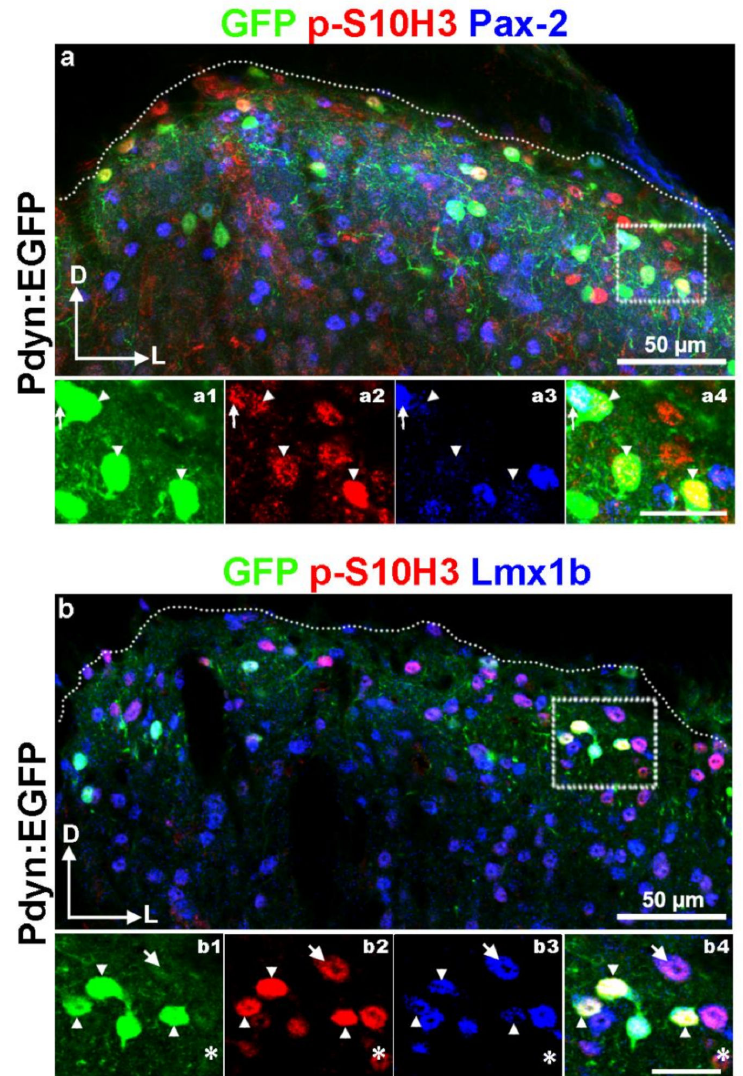
Figure 8. Burn injury-induced p-S10H3 nuclei are dominantly expressed by the excitatory subpop- ulation of dynorphinergic SDH neurons. ( a ) A representative image showing immunostaining for p-S10H3 (red), GFP (green) and Pax-2 (blue) in a transverse spinal cord section of Pdyn:enhanced green fluorescent protein (EGFP) mouse. In the inset ( a1 – a4 ) there are several anti-GFP antibody- labeled dynorphinergic neurons. Of these, there is only one p-S10H3-expressing Pdyn+ neuron that exhibits Pax-2-IR (labeled with an arrow), while the others lack Pax-2 (arrowheads; a1 – a4 ). ( b ) A representative image showing immunostaining for p-S10H3 (red), GFP (green) and Lmx1b (blue) in a transverse spinal cord section of Pdyn:EGFP mouse. In the insets ( b1 – b4 ), numerous p-S10H3-immunoreactive nuclei are visible in laminae I–IIo of the SDH. Of these, the majority express Lmx1b and thus presumably they are excitatory. While there are several p-S10H3+/Lmx1b+ neurons that proved to be dynorphinergic based on their strong cytoplasmic GFP-staining (arrowheads in the insets), there is only one that is non-dynorphinergic (indicated by an arrow). The asterisk indicates such a p-S10H3-IR neuron that is immunonegative both for Lmx1b and Pdyn. The dotted line represents the border between gray and white matter ( a , b ). D, dorsal; L, lateral. Scale bars in the insets are 20 µ